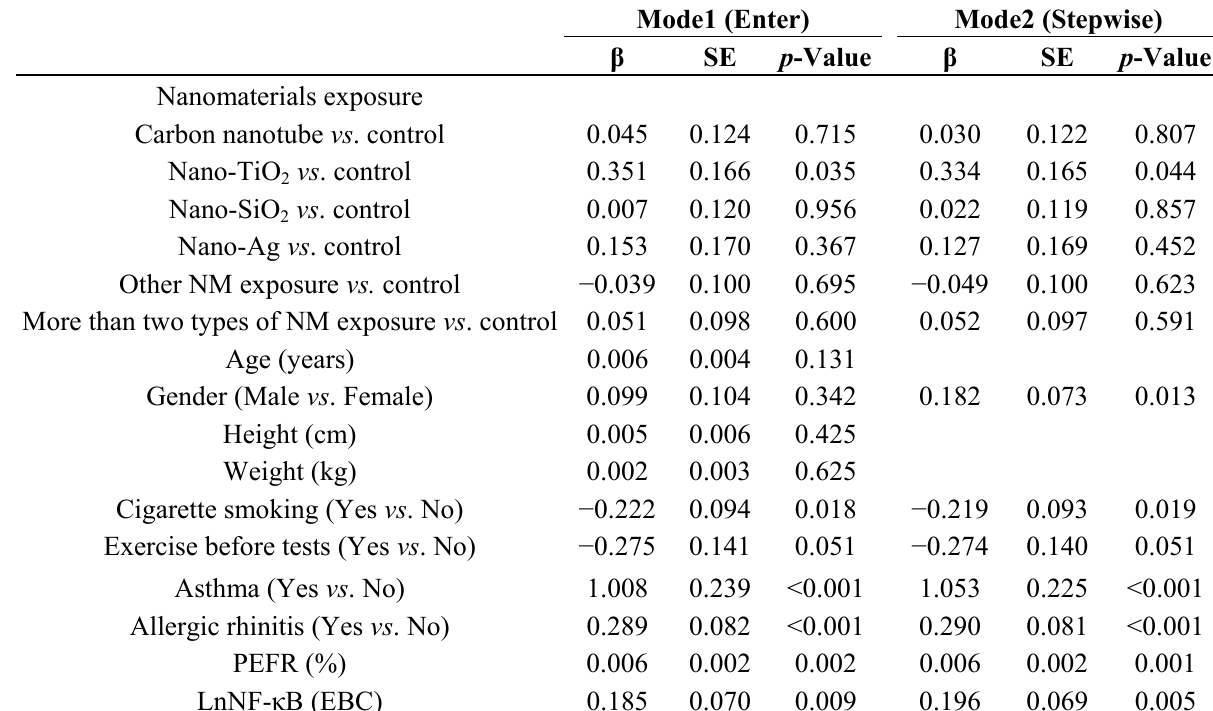
Table 4. Correlation of determinants of fractional exhaled nitric oxide (FENO) values in different nanomaterial exposed categories a